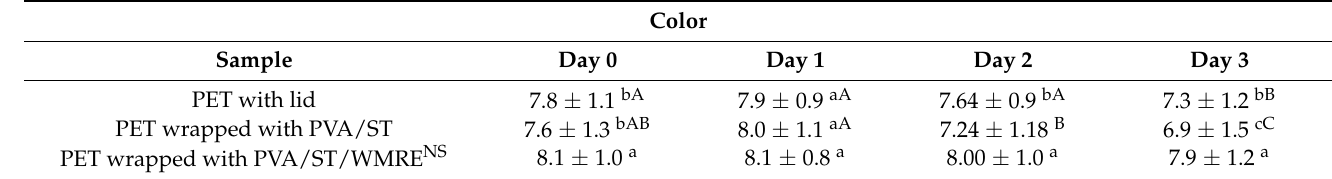
Table 5. Mean liking score and standard deviation of color of fresh-cut purple cabbage (n = 50).